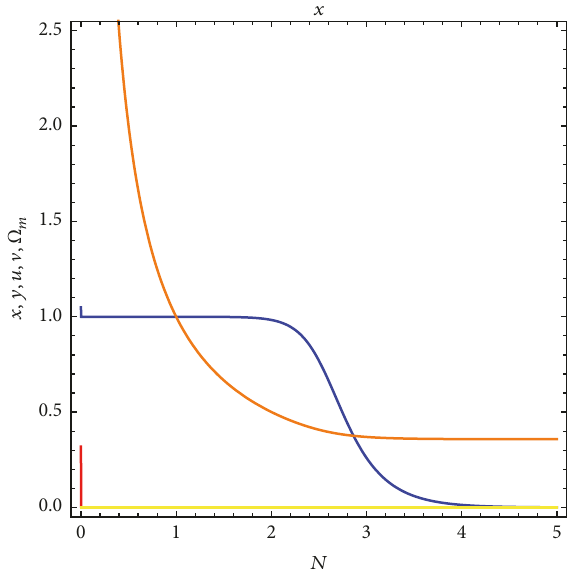
Figure 14: Plot of ( 14 ) variations of 𝑥 (blue), 𝑦 (green), 𝑢 (orange), V (red), and Ω 𝑁 near 𝑃 𝛾 = 1 , 𝛿 = 1/(4√6) , 푚 (yellow) versus 15 , for Figure 12: Plot of ( 12 ) variations of 𝑥 (blue), 𝑦 (green), 𝑢 (orange), and 𝜆 = −0.5 . The position corresponding to 𝑁 = 0 is the fixed point V (red), and Ω 𝑁 near 𝑃 𝛾 = 1 , 𝛿 = 1 , and 푚 (yellow) versus 13 , for under consideration. 𝜆 = −0.5 . The position corresponding to 𝑁 = 0 is the fixed point under consideration.